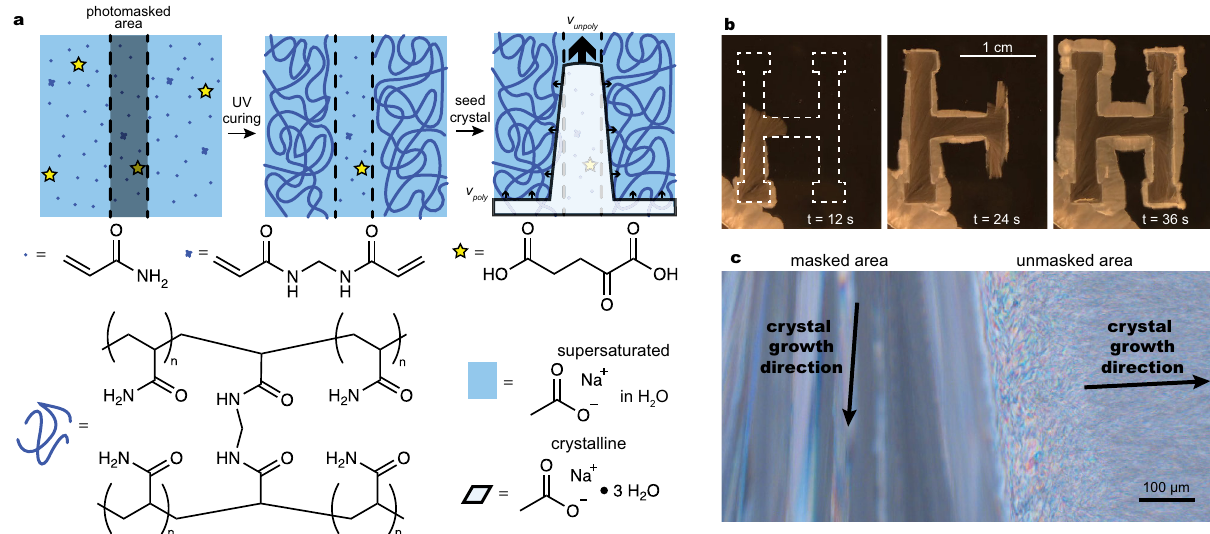
Fig. 1 Strategy for patterning crystal growth using photomasks and polymerizable additives in solution. a Scheme showing sequence of events. First, an aqueous prepolymer solution containing acrylamide monomers, N,N ′ -methylenebisacrylamide (a crosslinker), α -ketoglutaric acid (a photoinitiator), and supersaturated sodium acetate is injected into a fl at channel and overlaid with a photomask. Next, the system is exposed to ultraviolet light, causing photopolymerization to selectively occur in unmasked areas. Finally, the system is nucleated with a seed crystal of sodium acetate trihydrate, resulting in fast crystal growth through the masked, unpolymerized areas (velocity shown as v unpoly ) and slower crystal growth through the unmasked regions (velocity shown as v poly , where v poly < v unpoly ). b Photos taken at 12-s intervals of sodium acetate trihydrate crystal growth through and around a masked region shaped like the letter H. Precursor solution composition: 7.0 M sodium acetate, 2.8 M acrylamide, 26 mM N,N ′ -methylenebisacrylamide, 2 mM α - ketoglutaric acid in water. Full video available (Supplementary Movie 1). c Photomicrograph of transmitted light through a crystalline sample between crossed linear polarizers. This image shows the interface between the masked and unmasked regions of a sample after crystallization; the birefringence of the crystals enables the visualization of discrete crystalline domains, which are large in the masked region and small in the unmasked region. Videos capturing the temporal evolution of crystal growth using this technique are available (Supplementary Movies 2 and 3); electron micrographs of the unmasked region at greater magni fi cation are available in Supplementary Figs. 1 and 2. Precursor solution is the same as in ( b